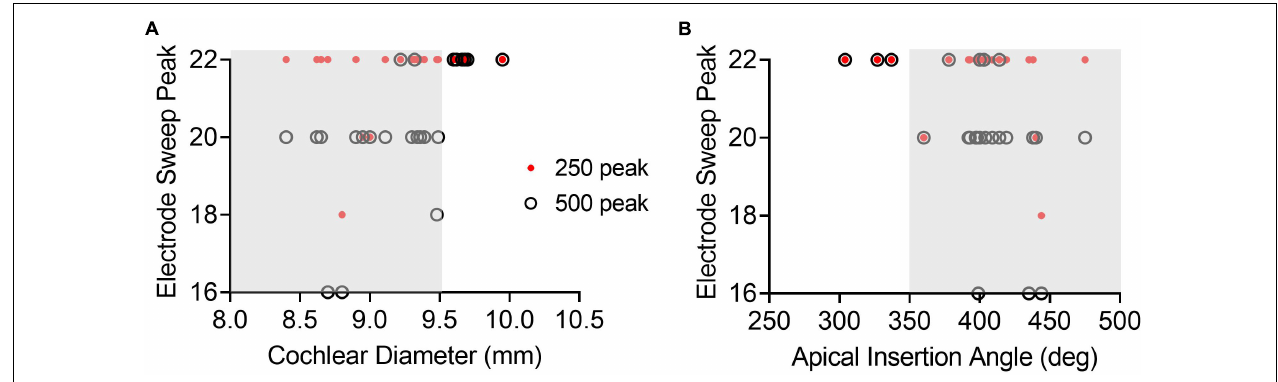
FIGURE 9 | The shorter the cochlear diameter ( < 9.5 mm) and the deeper the apical insertion angle ( > 350 degrees), the more likely the 500-Hz maximum on the electrode sweep would present at a more basal intracochlear electrode than the most-apical one (i.e., the more likely the electrode is to cross the CF place for 500-Hz). (A) Maximum ECochG response along the entire array for both 250- and 500-Hz (i.e., electrode sweep maximum) as a function of cochlear diameter. The gray region highlights that for cochlear diameter < 9.5 mm, where there may be a possibility that the perimodiolar electrode may pass the 500-Hz CF during the insertion. (B) Maximum ECochG response on electrode sweep for both 250- and 500-Hz as a function of apical insertion angle. For apical insertion angles > 350 degrees, there is a possibility that the electrode may pass the CF for 500-Hz during the insertion. Electrode sweep peak is numbered from 1–22, where 22 is the most-apical electrode and 1 is the most basal